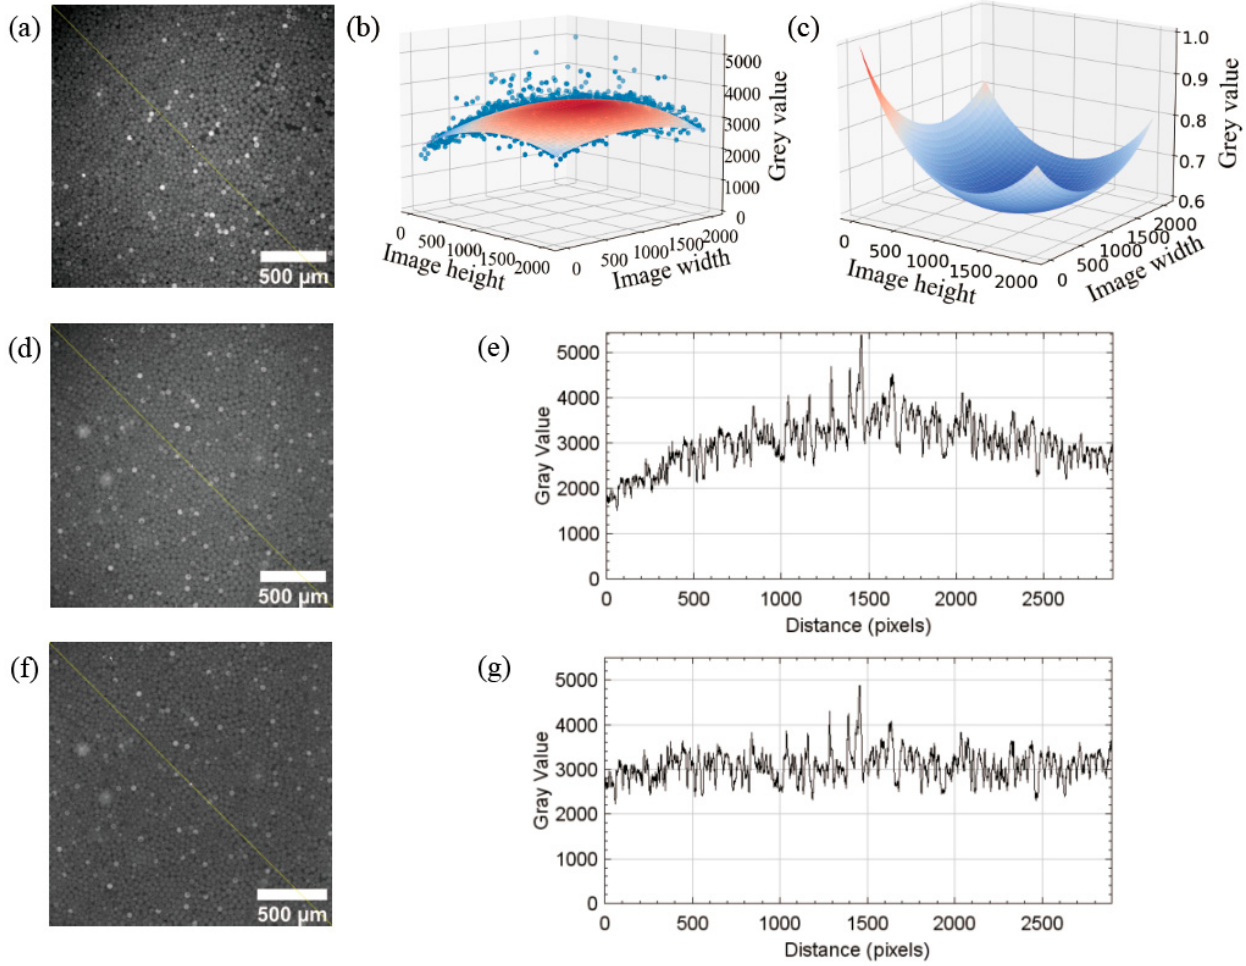
Figure 3. Quantification of droplet signal intensity value in the fluorescence image. ( a ) The template image was used for vignetting correction. ( b ) The fitting surface was obtained from sampling and polynomial fitting of the asymptotic halo compensation image. ( c ) The calculated normalized vignetting compensation model. ( d ) A droplet image of the fluorescent channel without accretion correction. ( e ) The gray value curve is plotted along the yellow diagonal in ( d ). In the absence of asymptotic halo correction, the gray value curve shows a peak shape as a whole. ( f ) The image of ( d ) after vignetting correction. ( g ) The gray value curve is drawn along the yellow diagonal in ( f ). After vignetting correction, the grayscale curve is flat and the image vignetting is corrected. The vignetting corrected images are automatically classified into two classes of positive and negative droplets using the unsupervised learning k-means clustering algorithm. k- means algorithm achieves the classification of positive and negative droplets mainly by minimizing the value of the intra-cluster variance [43]. The scatter plot of the k-means algorithm clustered positive and negative droplet signals is shown in Figure 4a, and the clustering results of positive droplets and negative droplets are labeled in Figure 4b,c, respectively, in the fluorescence channel images, where the positive droplets